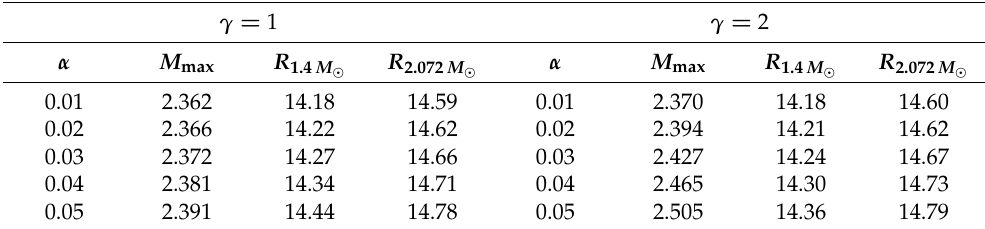
Table 12. Maximum mass ( M max ) in unit of M (cid:12) and radius (km) at M = 1.4 M (cid:12) ( R 1.4 M radius (km) at M = 2.072 M (cid:12) ( R 2.072 M B 0 = 2.5 × 10 18